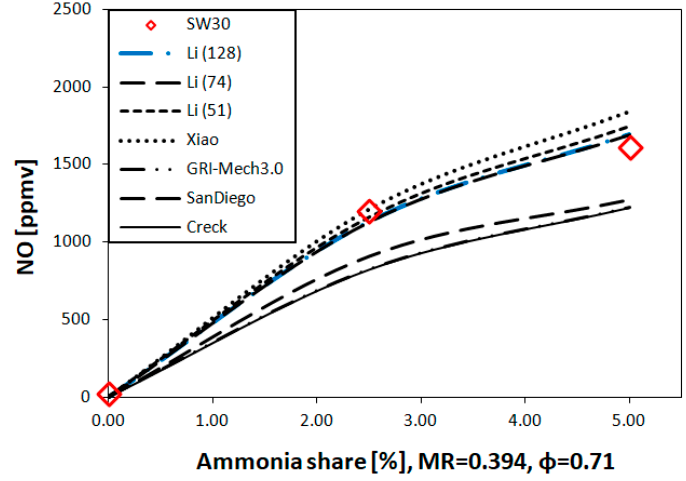
Figure 10. Comparison of kinetic reaction mechanisms in a function of ammonia share in fuel with